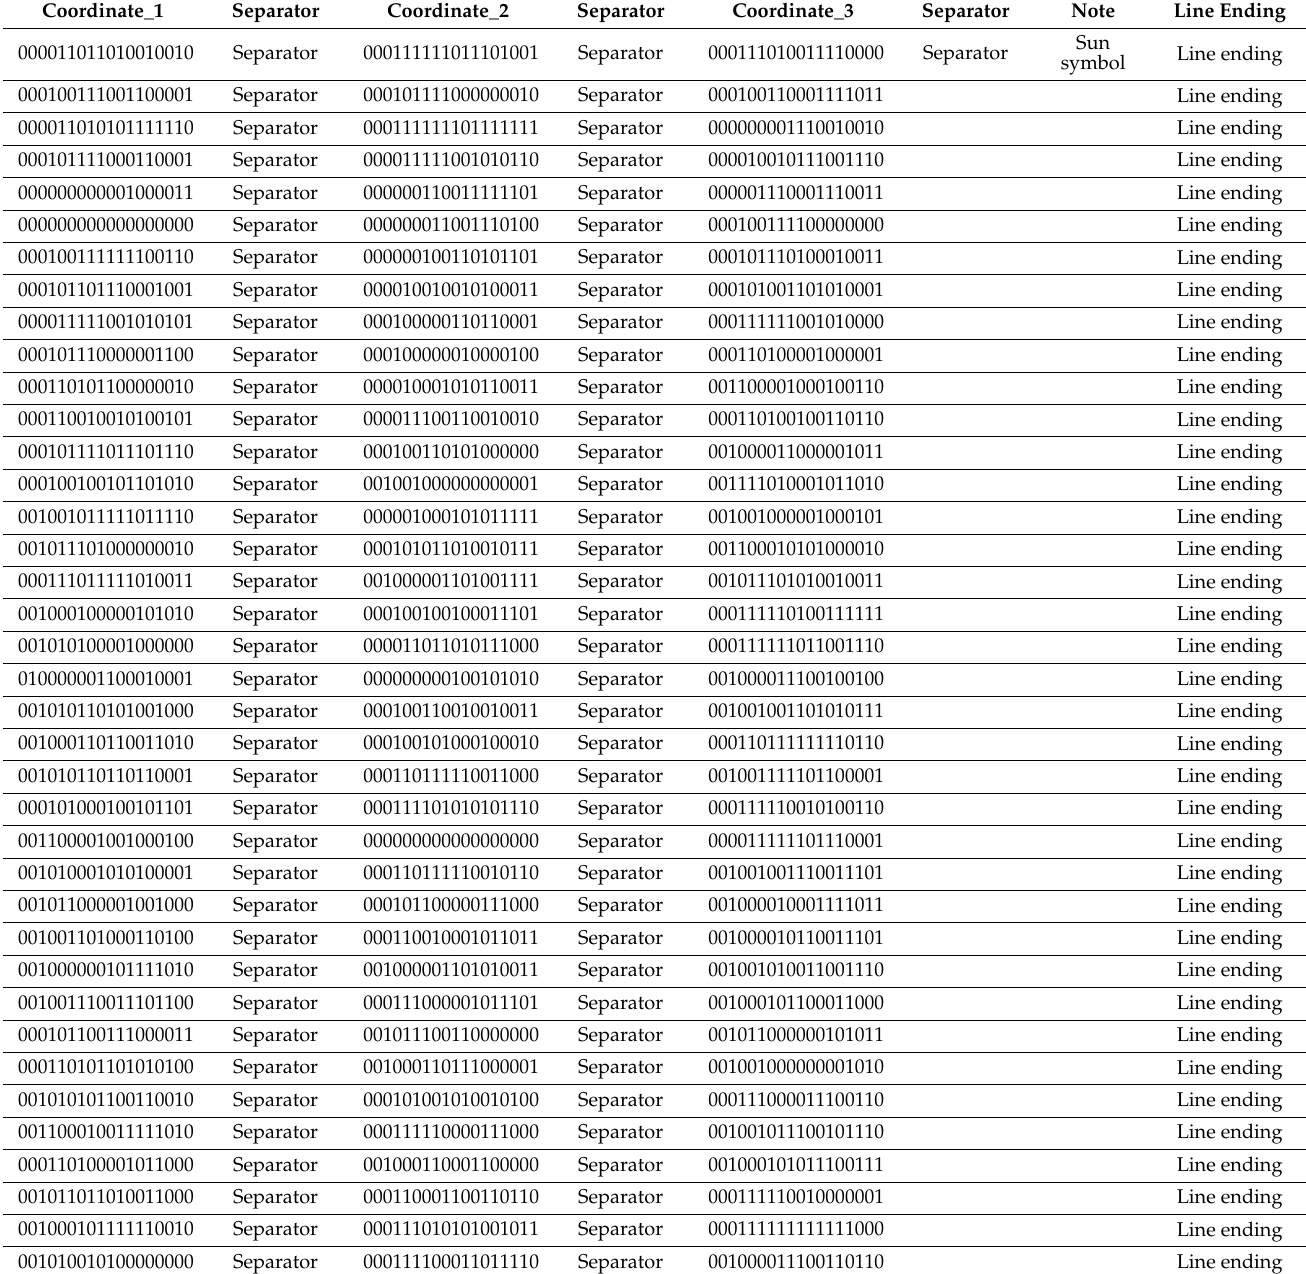
Table A1. The coordinates 1, 2, and 3 are the X, Y, Z in Cartesian coordinates, converted from the Dec, RA, and the distance from the Sun. The original point is the Sun, and the X-Y is the equatorial plane, the Z is the elevation. However, the transform will induce some negative coordinates, so we just shift them to nonnegative